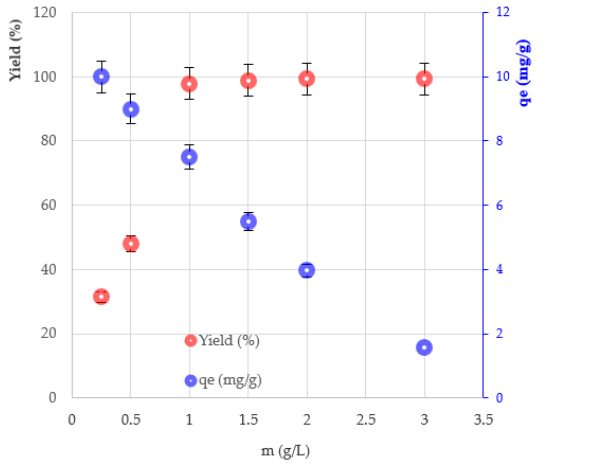
7 of 19 Figure 3. Effect of contact time and initial concentration of dyes: ( a ) MB; ( b ) MG on the adsorption capacity of 4AZW (S/L = 1 g/L, T = 25 ± 1 °C and unadjusted pH). The qe values of both MB and MG sharply increased from 10 min to 50 min and bal- anced beyond 70 min contact time. This can be related to the number of initially vacant surface sites at the beginning. Over time, repulsive forces between the cationic dye mole-